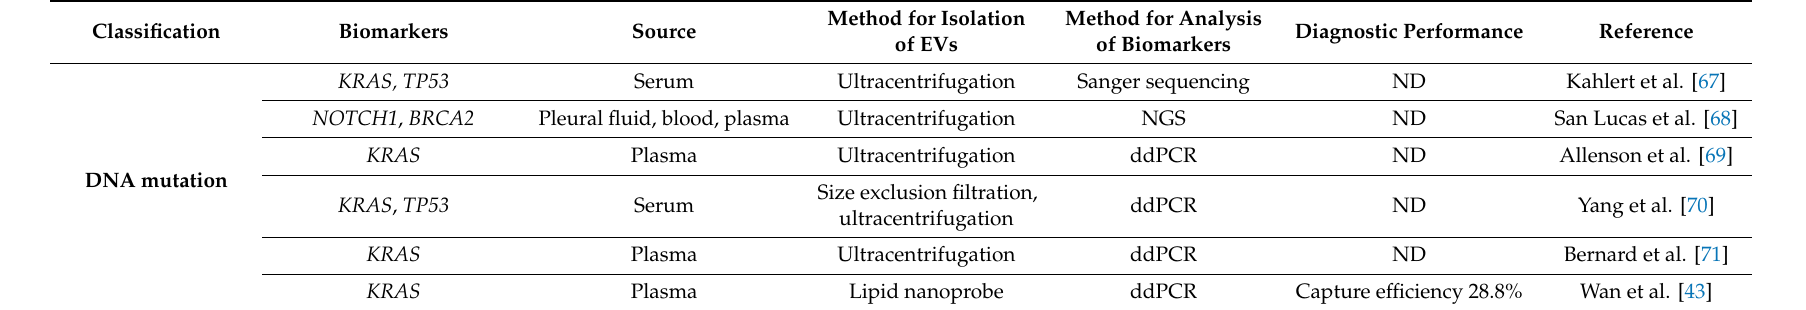
Table 2. Panels of EV DNA biomarkers for early detection and diagnosis of pancreatic